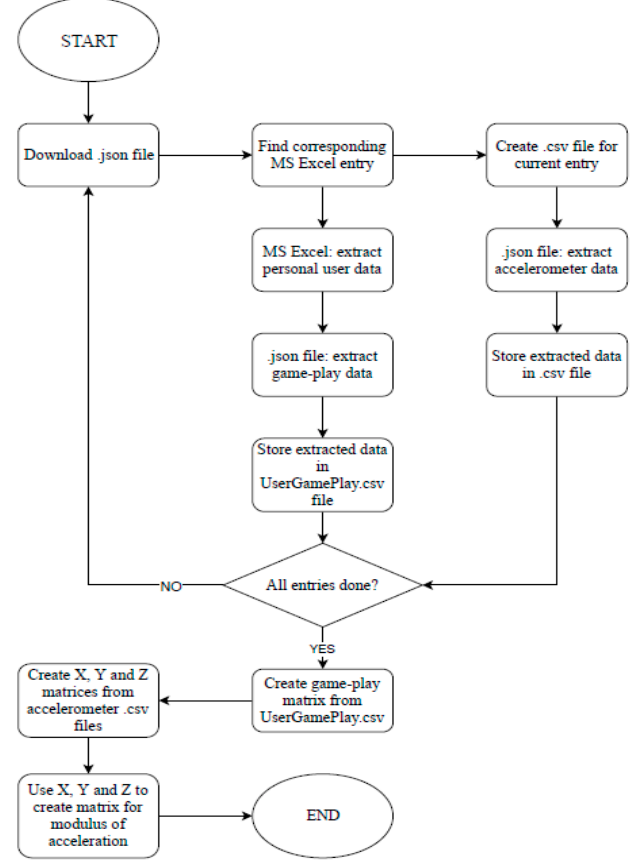
Figure 3. Data Extraction Process.